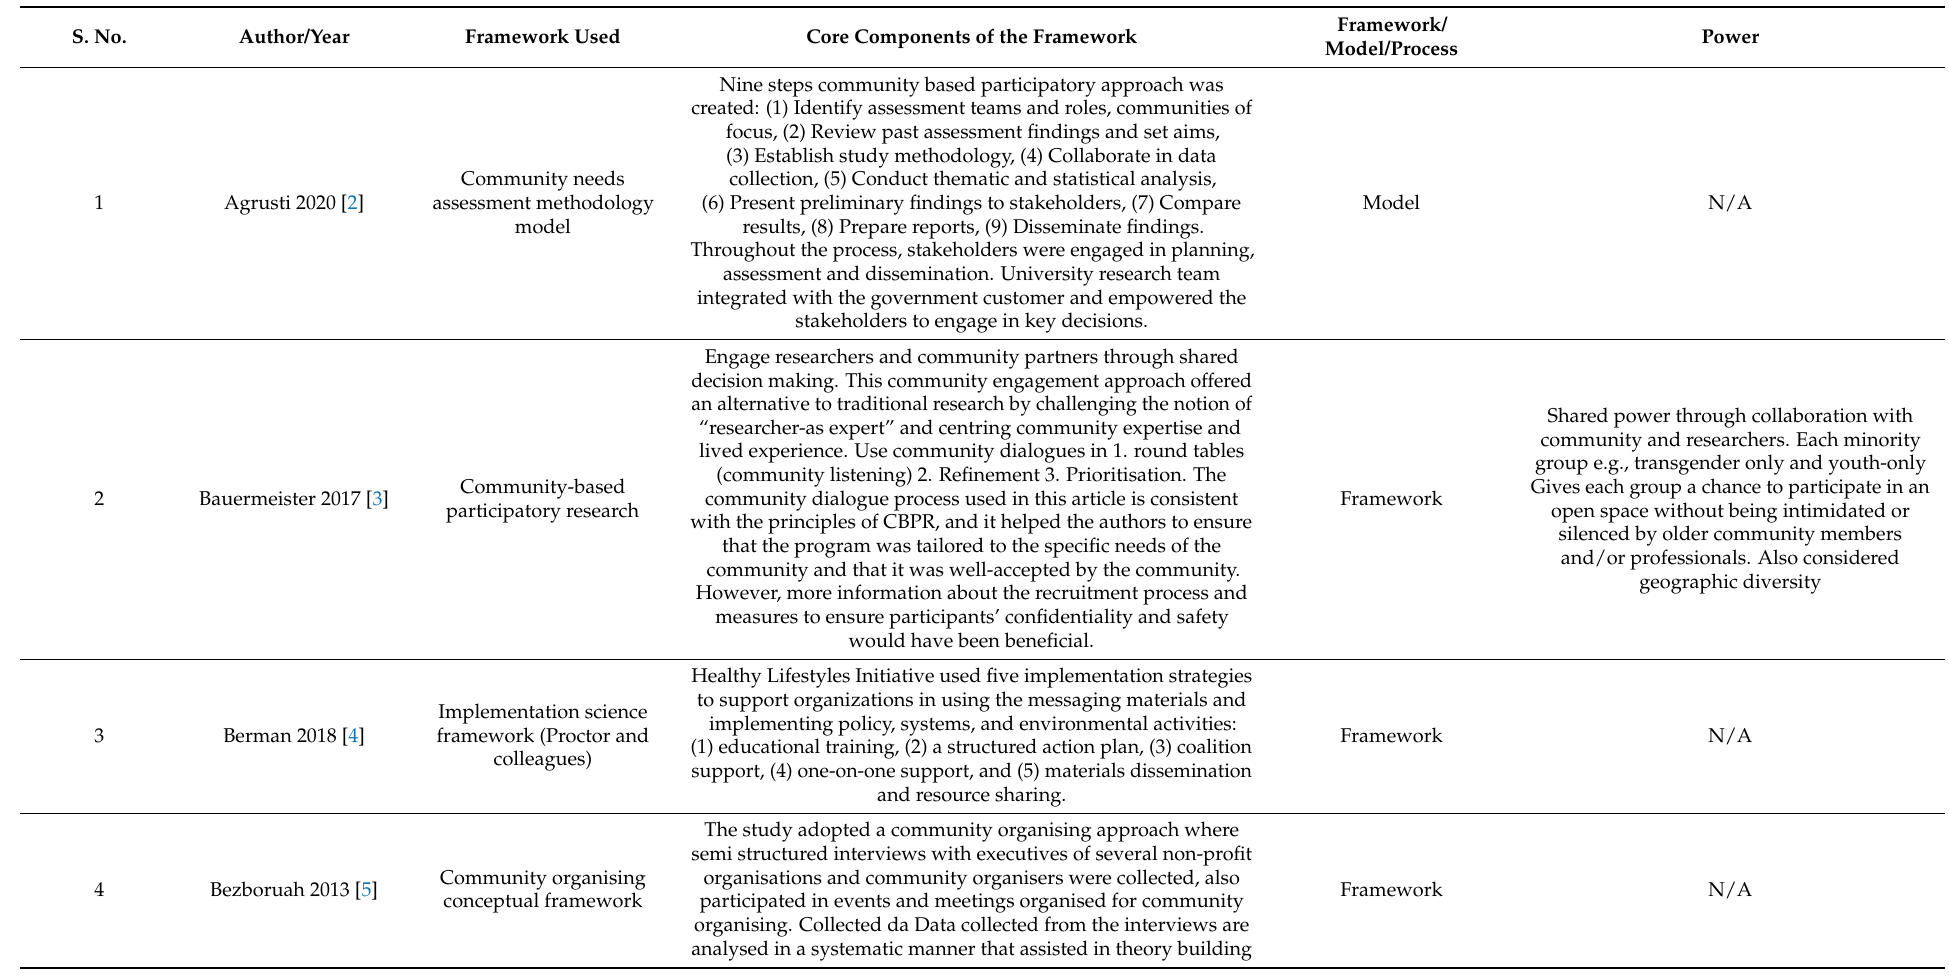
Table 2. Core components of frameworks/model/process and details of selected studies (n =